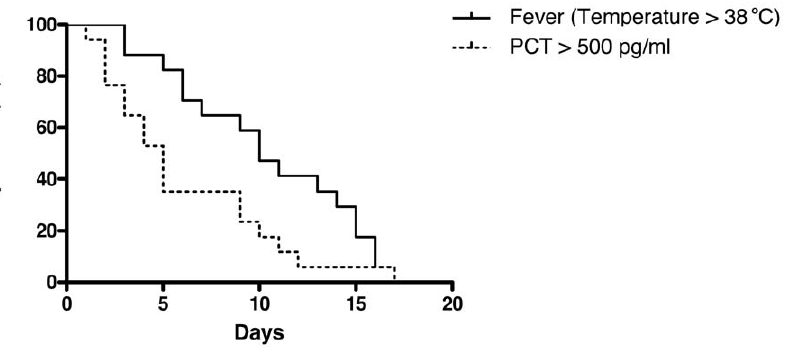
Figure 5. Percent of patients with PCT . 500 pg/ml and fever (temperature . 38 6 C) in follow-up of IFD. The T0 for PCT and fever is set on the time point at which the first positive PCT value ( . 500 pg/ml) has been documented.